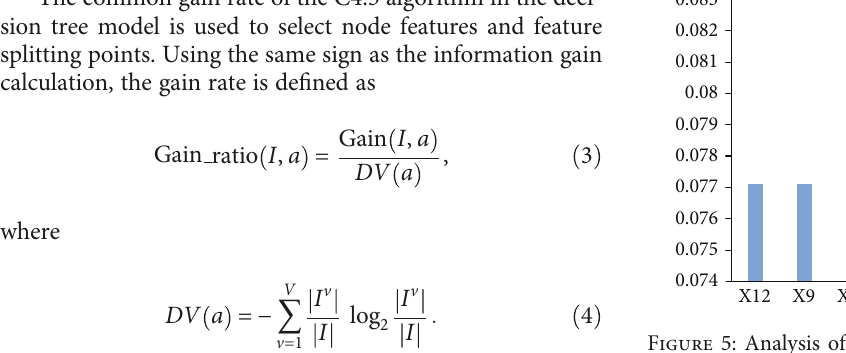
Figure 5: Analysis of the importance of independent variables to the